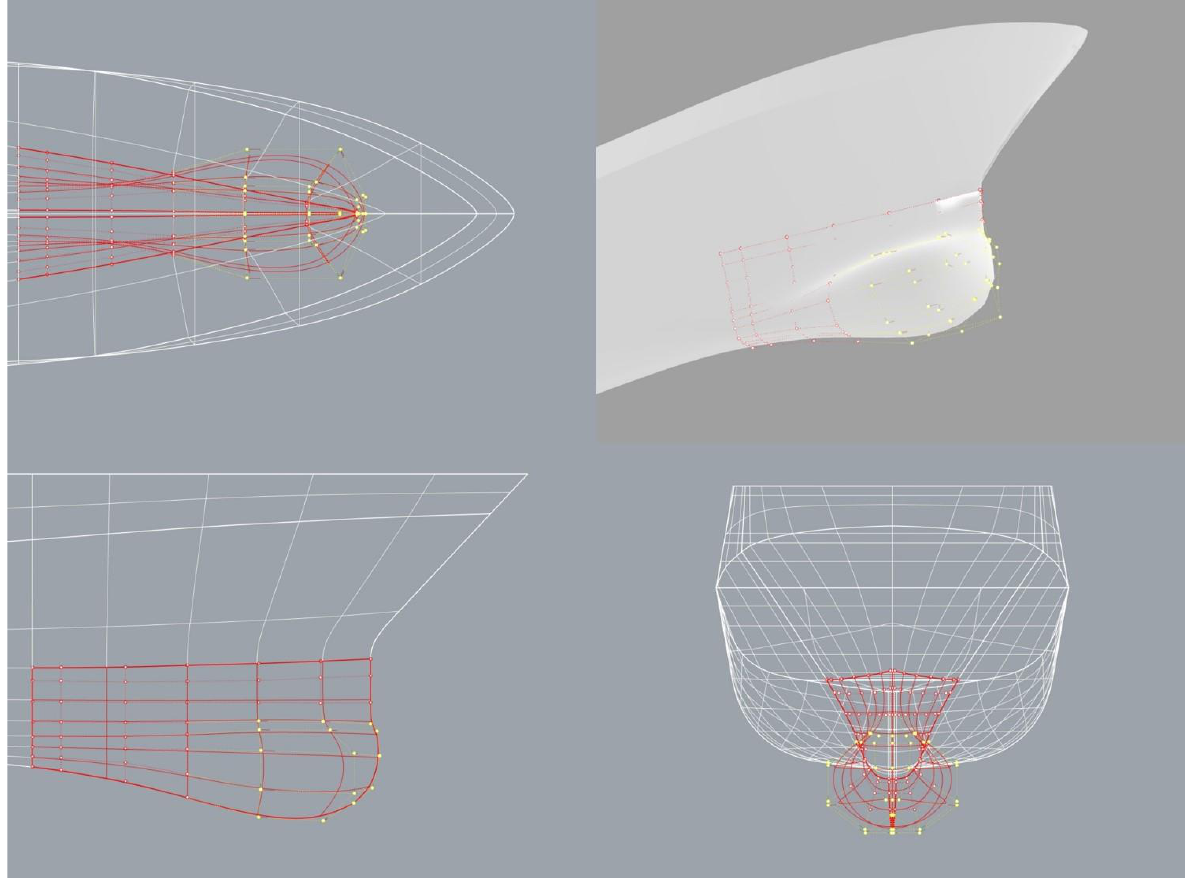
Figure 2. The details of the distribution of the control points around the original sonar dome, i.e., F0. The white and red lines are the surface outlines of the ship hull and sonar dome, respectively. The red hollow points are the control points on the sonar dome. The yellow hollow points are selected to protrude the dome geometry.